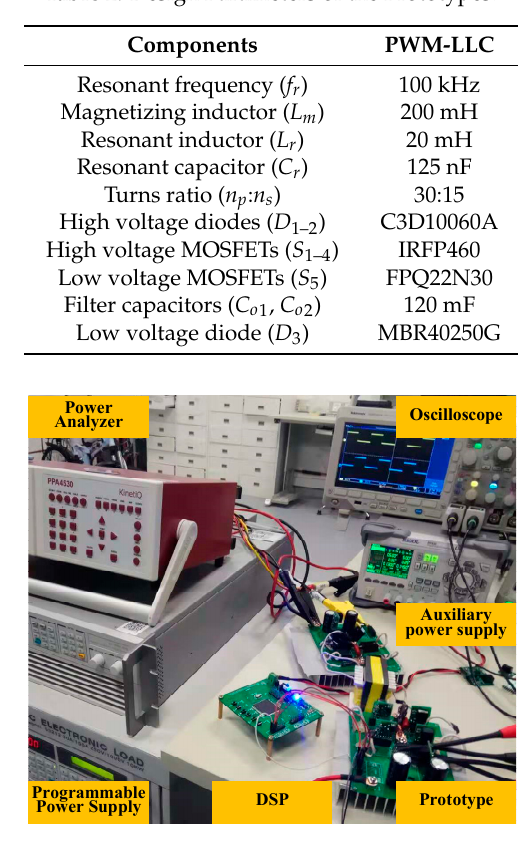
Figure 7. Experimental Prototype.